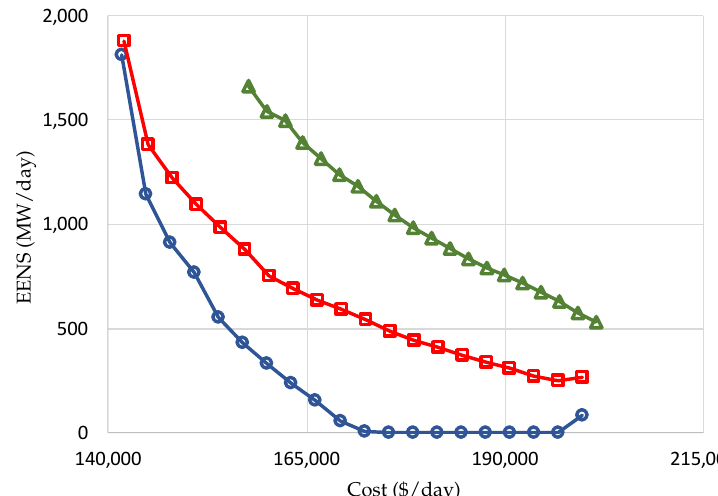
Figure 6. Cost vs. EENS Pareto set for Scenario 1 (– ◦ – blue), Scenario 2 (– (cid:3) – red), and Scenario 3 (– (cid:52) –